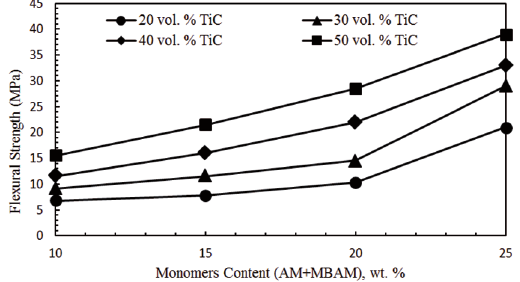
Figure 11: The bending stress of green gelcast TiC with varied solid loading as a function of monomer content.